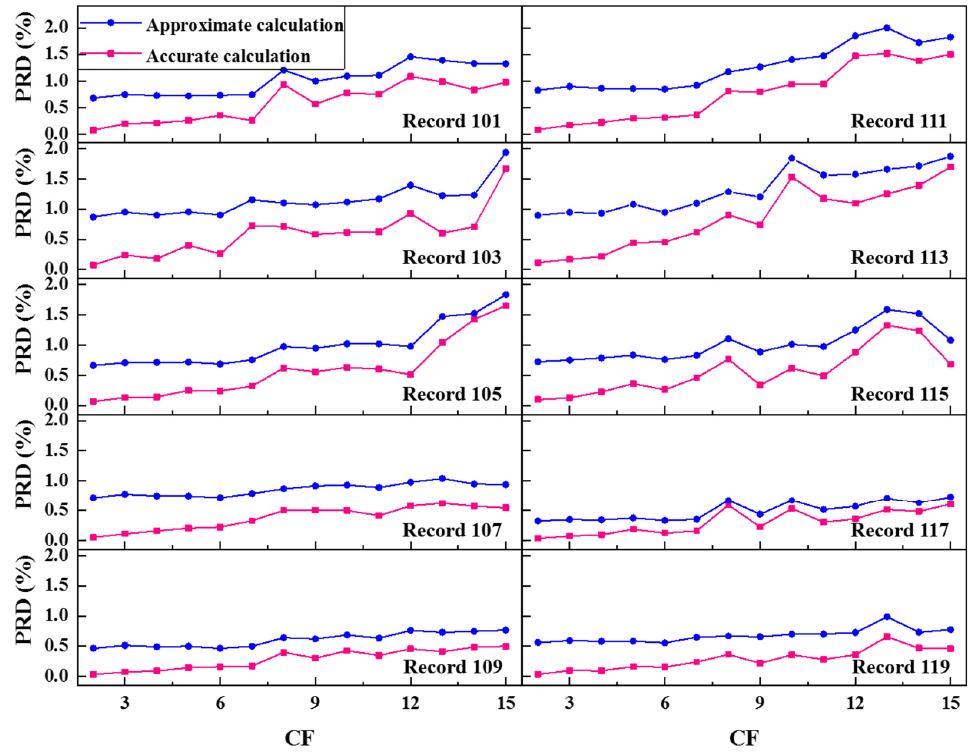
Figure 7. The PRD of reconstruction signal of ten Records for two different calculation methods.